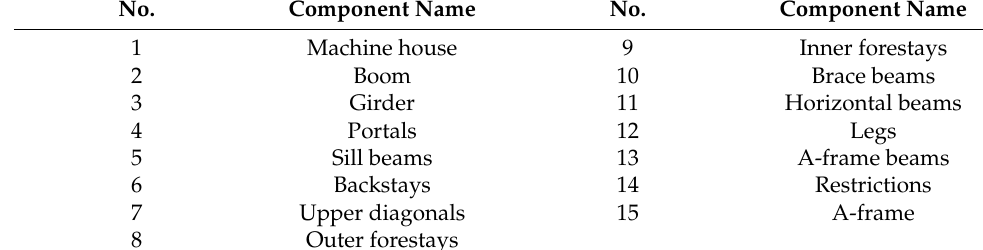
dimensions of 3.33 × 6.67 × 10 m 3 (500 × 1000 × 1500 m 3 for prototype model) to ensure